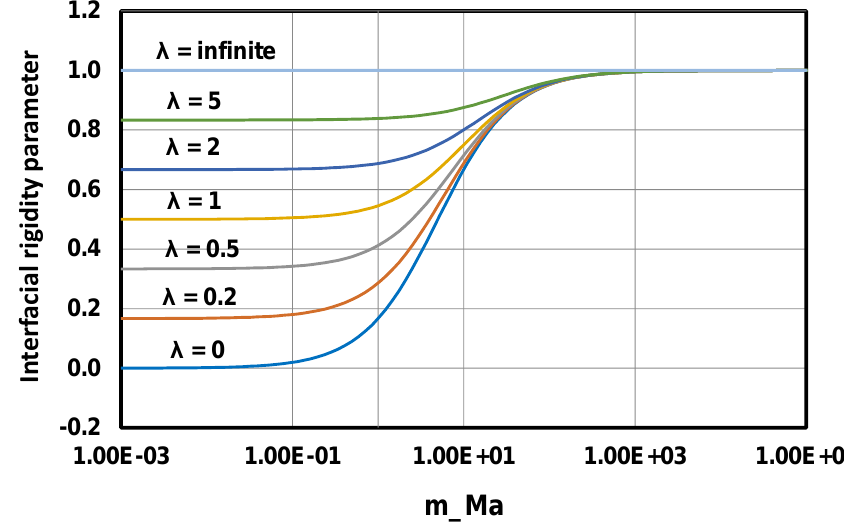
Figure 22. Plots of ε r versus m _ Ma for emulsions for different values of the viscosity ratio λ .